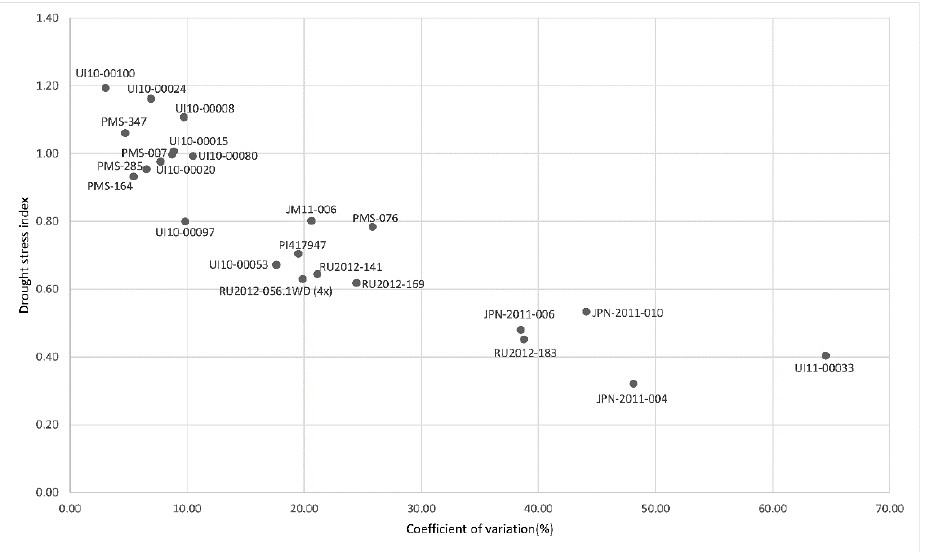
Figure 1. Scatter plot of coefficient of variation and drought stress index of the Soil Plant Analysis Development (SPAD) Chlorophyll meter value in screening experiment at Hokkaido University, Sapporo, Japan of drought-stress tolerance. Scatter points encircled by solid circles represent resistant genotypes. Scatter points encircled by dotted circles represent susceptible genotypes.